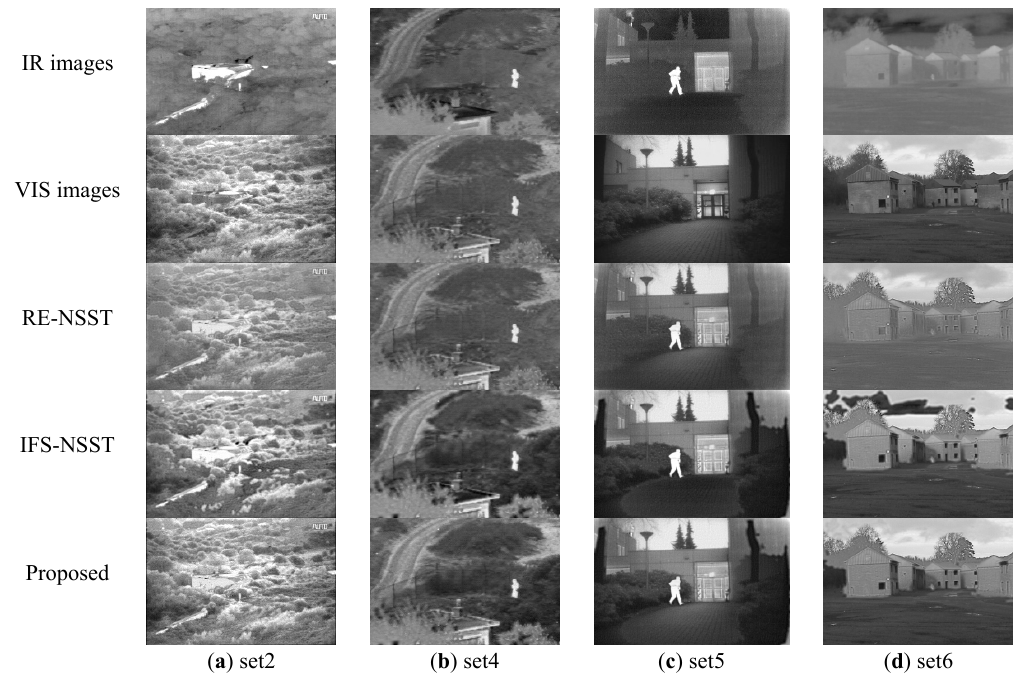
Figure 4. The fusion results in TNO Dataset. The first and second rows are the IR and VIS images. From the third to the fifth row are the fusion results of RE-NSST, IFS-NSST and Proposed methods fifth row are the fusion results of RE-NSST, IFS-NSST and Proposed methods on 4 sets of the source images. on 4 sets of the source images.